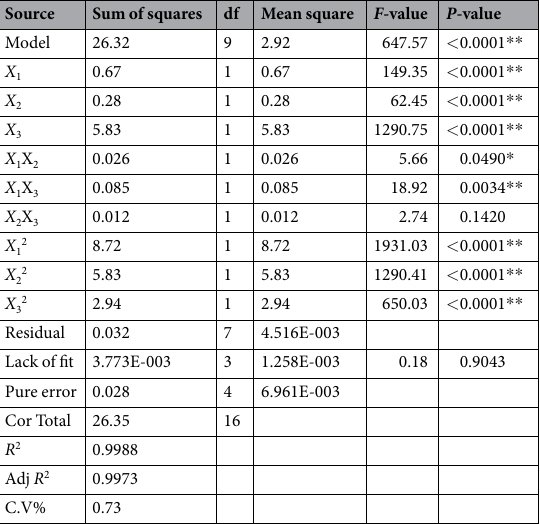
Table 2. ANOVA for response surface quadratic model of ACPs extraction. * P values < 0.05 were considered to be significant. ** P values < 0.01 were considered to be highly